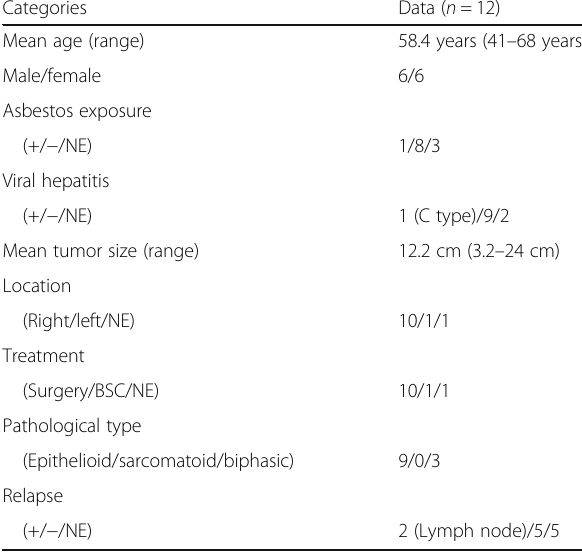
Table 1 Summary of hepatic mesothelioma